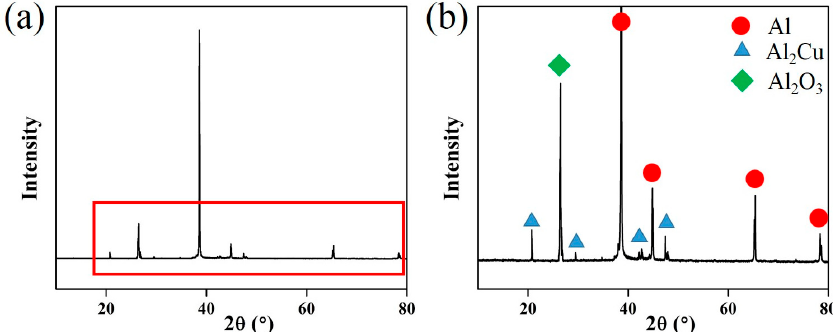
Figure 9. ( a ) XRD analysis of UHTI; ( b ) partially enlarged picture of the XRD graph.